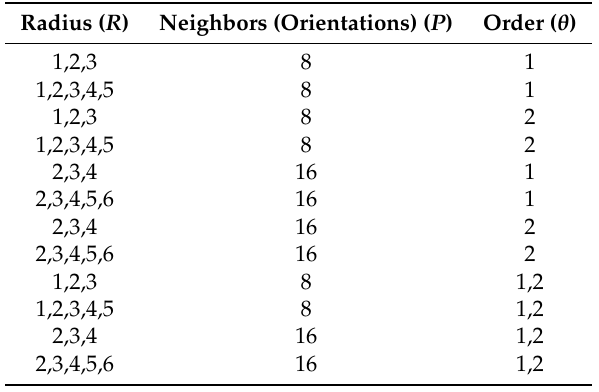
Table 4. Each row describes the parameters used to compute different M-CLOSIBs and HM-CLOSIBs in the experiments. Several values for a parameter indicate that we obtained CLOSIB as a concatenation of the CLOSIBs for each single